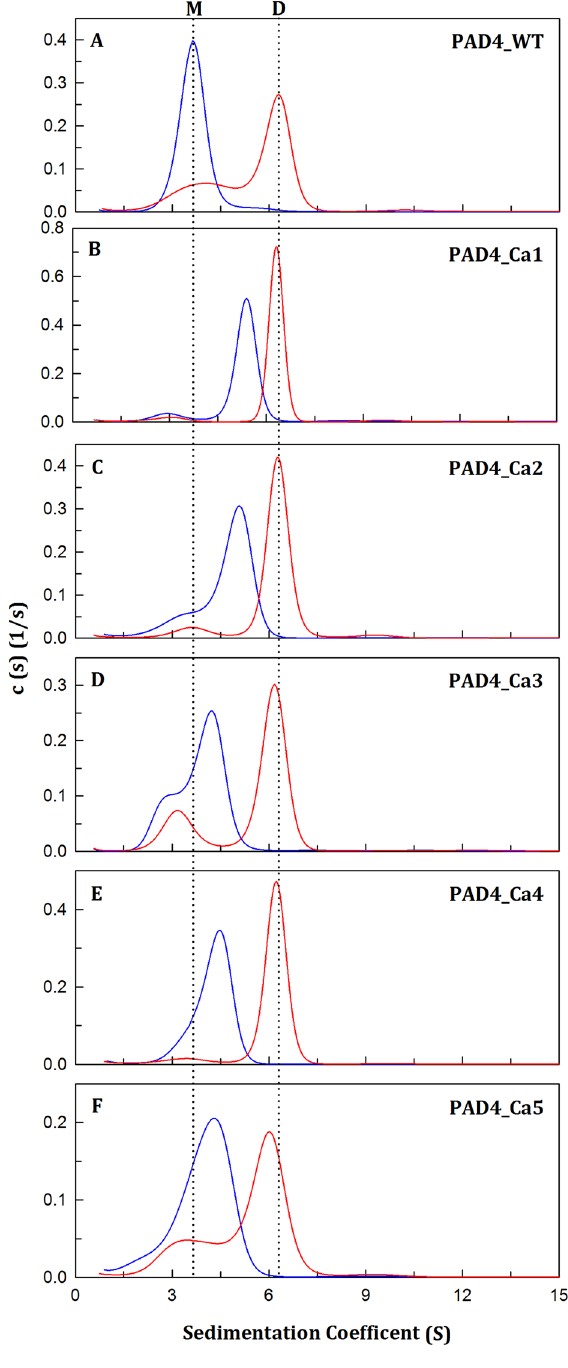
Figure 4. Dissociation-reassociation of human PAD4 WT and the calcium-binding-site mutant enzymes. The PAD4 WT and the calcium-binding-site mutant enzymes were treated with 1.2 M urea in 50 mM Tris- HCl buffer (pH 7.4) at 25 °C for 16 h, and the protein samples were then diluted 10-fold to reduce the urea concentration to 0.12 M. ( A ) PAD4_WT. ( B ) PAD4_Ca1. ( C ) PAD4_Ca2. ( D ) PAD4_Ca3. ( E ) PAD4_Ca4. ( F ) PAD4_Ca5. Blue line: the enzyme treated with 1.2 M urea. Red line: 10-fold dilution of the 1.2 M urea-treated enzyme (0.12 M